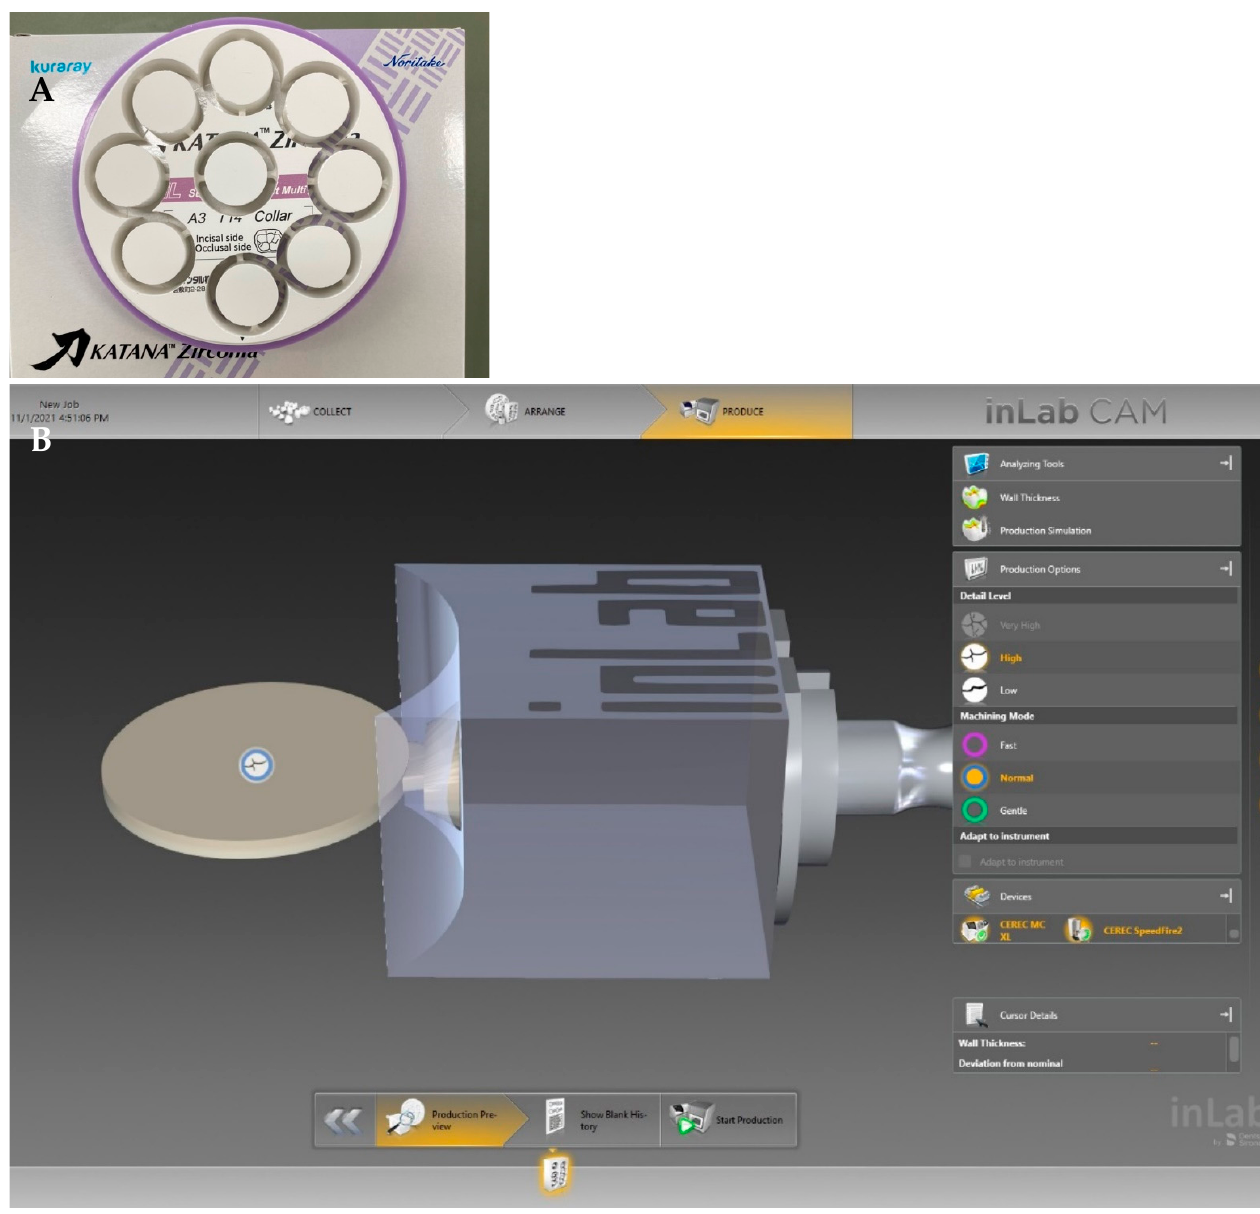
Figure 3. Preparation of the zirconia specimens by milling of big zirconia disc into a cylinder shape and then cutting into smaller discs for the regular sintering ( A ) and milling of the zirconia block into smaller discs for the speed sintering ( B ).